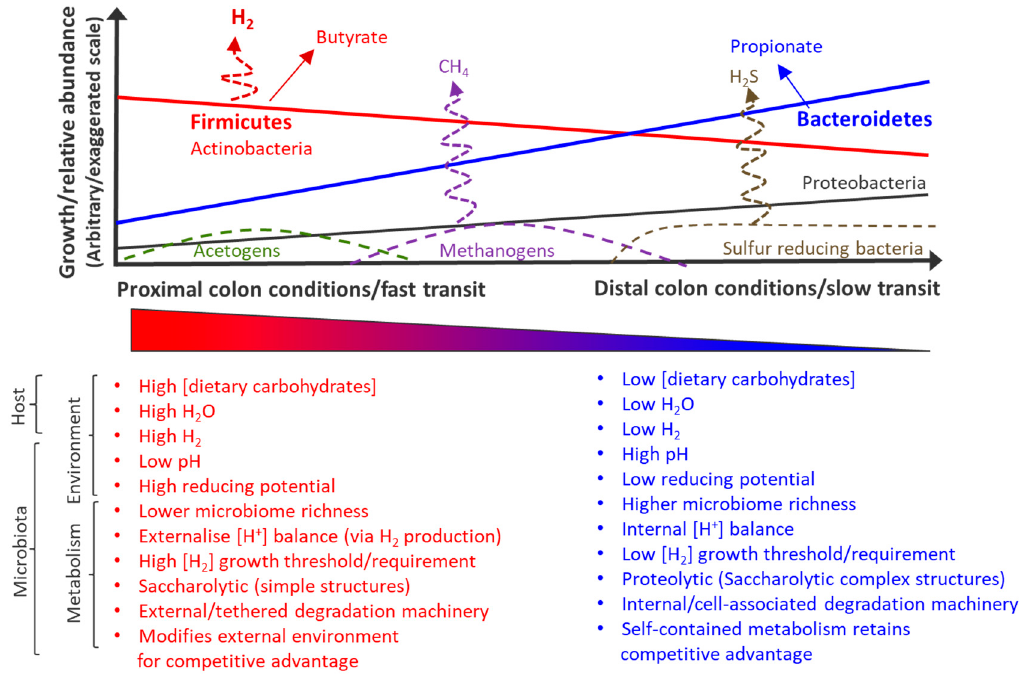
Figure 2. Schematic representation of conditions gradient in the colon determining state of gut ecosystem and how this effects faecal snapshots. Local/regional conditions in the gut graphically represented, left to right, from entry (proximal colon) to exit (distal colon).